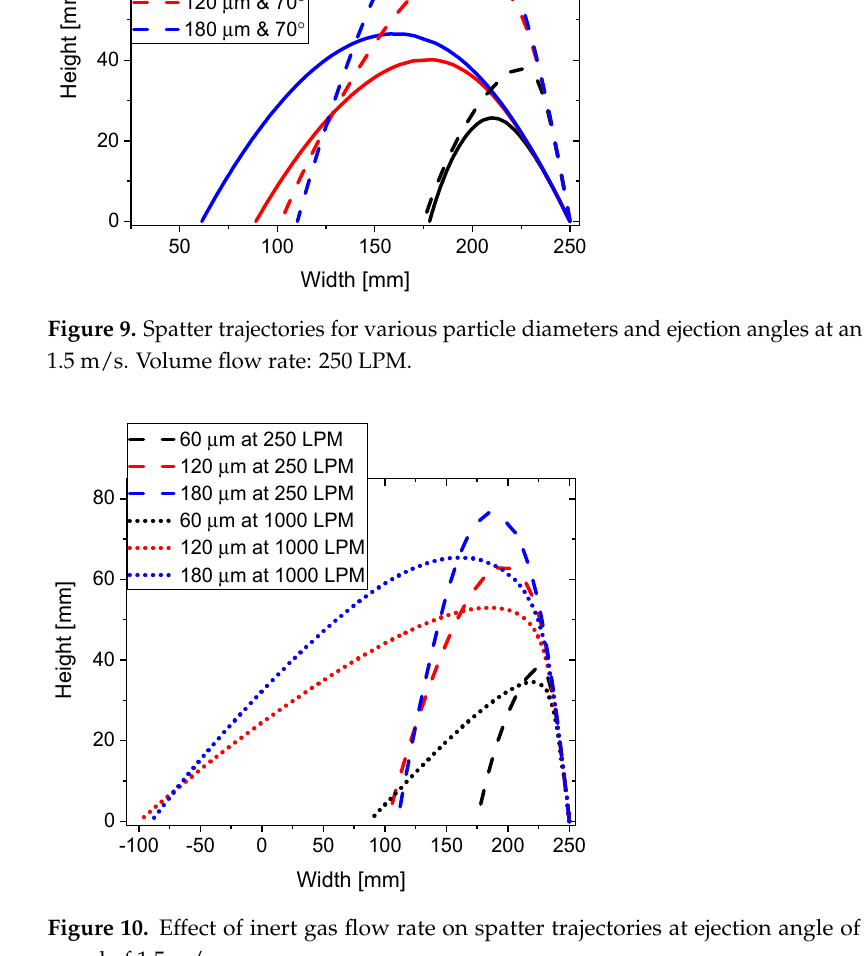
Figure 10. Effect of inert gas flow rate on spatter trajectories at ejection angle of 70° and ejection speed of 1.5 m/s.